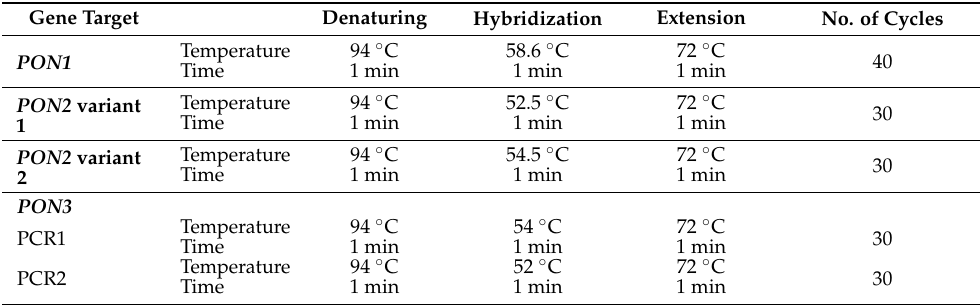
Table 2. Conditions of the amplification of PON1 , PON2 variants, and PON3 transcription products by